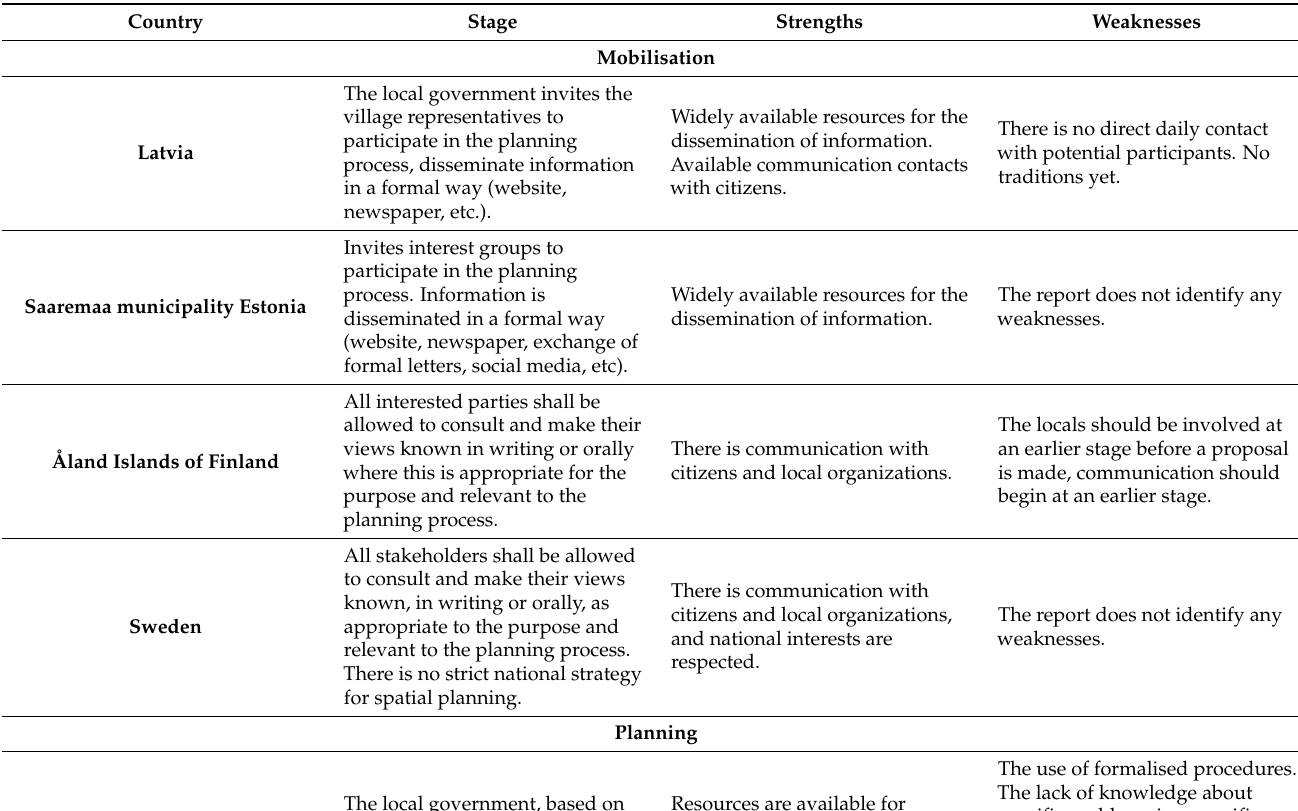
Table A1. Spatial planning process steps (mobilization, planning, implementation, and